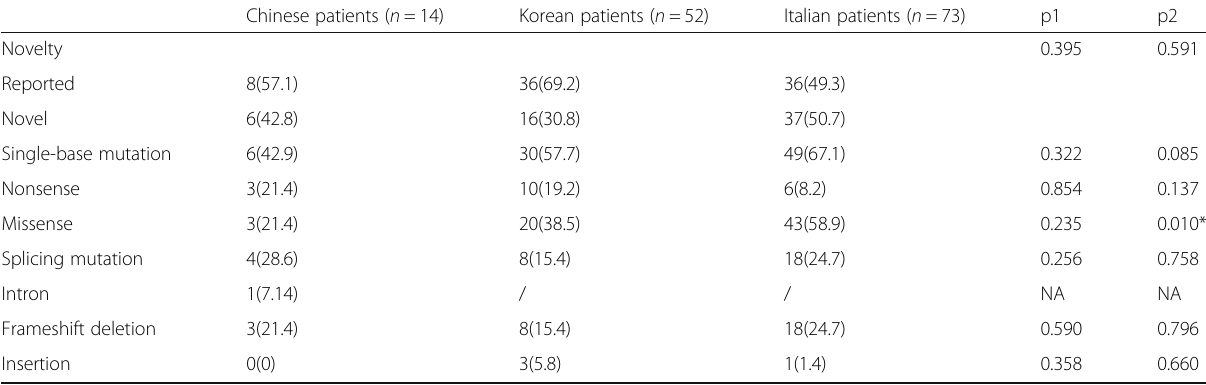
Table 3 Comparisons of NF1 mutation spectra between Chinese and patients from other parts of the